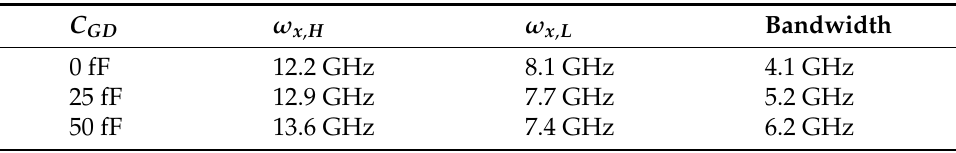
Table 1. Calculated ω x , H , ω x , L , Bandwidth with Different C GD